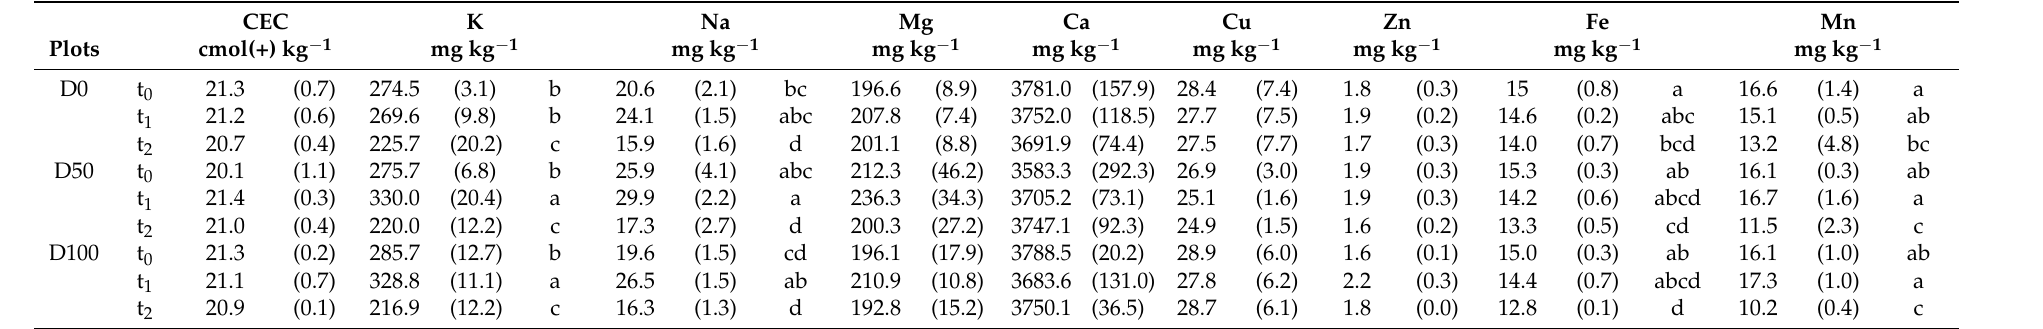
Table 5. Soil cation exchange capacity (CEC), exchangeable bases (K, Na, Mg, Ca) and available metal content (Cu, Zn, Fe, Mn) in the soil (depth = 0–20 cm) under different fertilization treatments (D0, D50, D100) and at different sampling times (t 0 , t 1 , t 2 ) (means followed by standard error in brackets). Different letters indicate significant differences between soil samples at p ≤ 0.05 (Fisher LSD